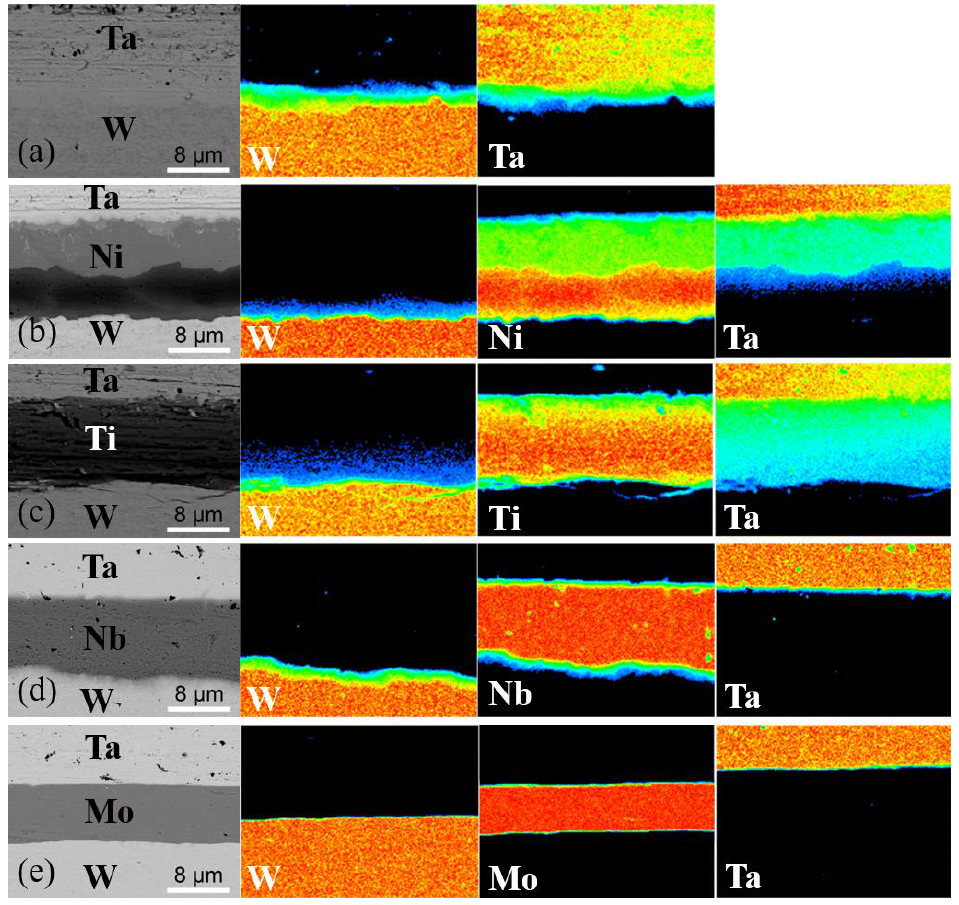
Figure 9. The surface scanning analyses of various W / Ta laminates with di ff erent transition layers, ( a ) W / Ta, ( b ) W / Ni / Ta, ( c ) W / Ti / Ta, ( d ) W / Nb / Ta, ( e ) W / Mo /